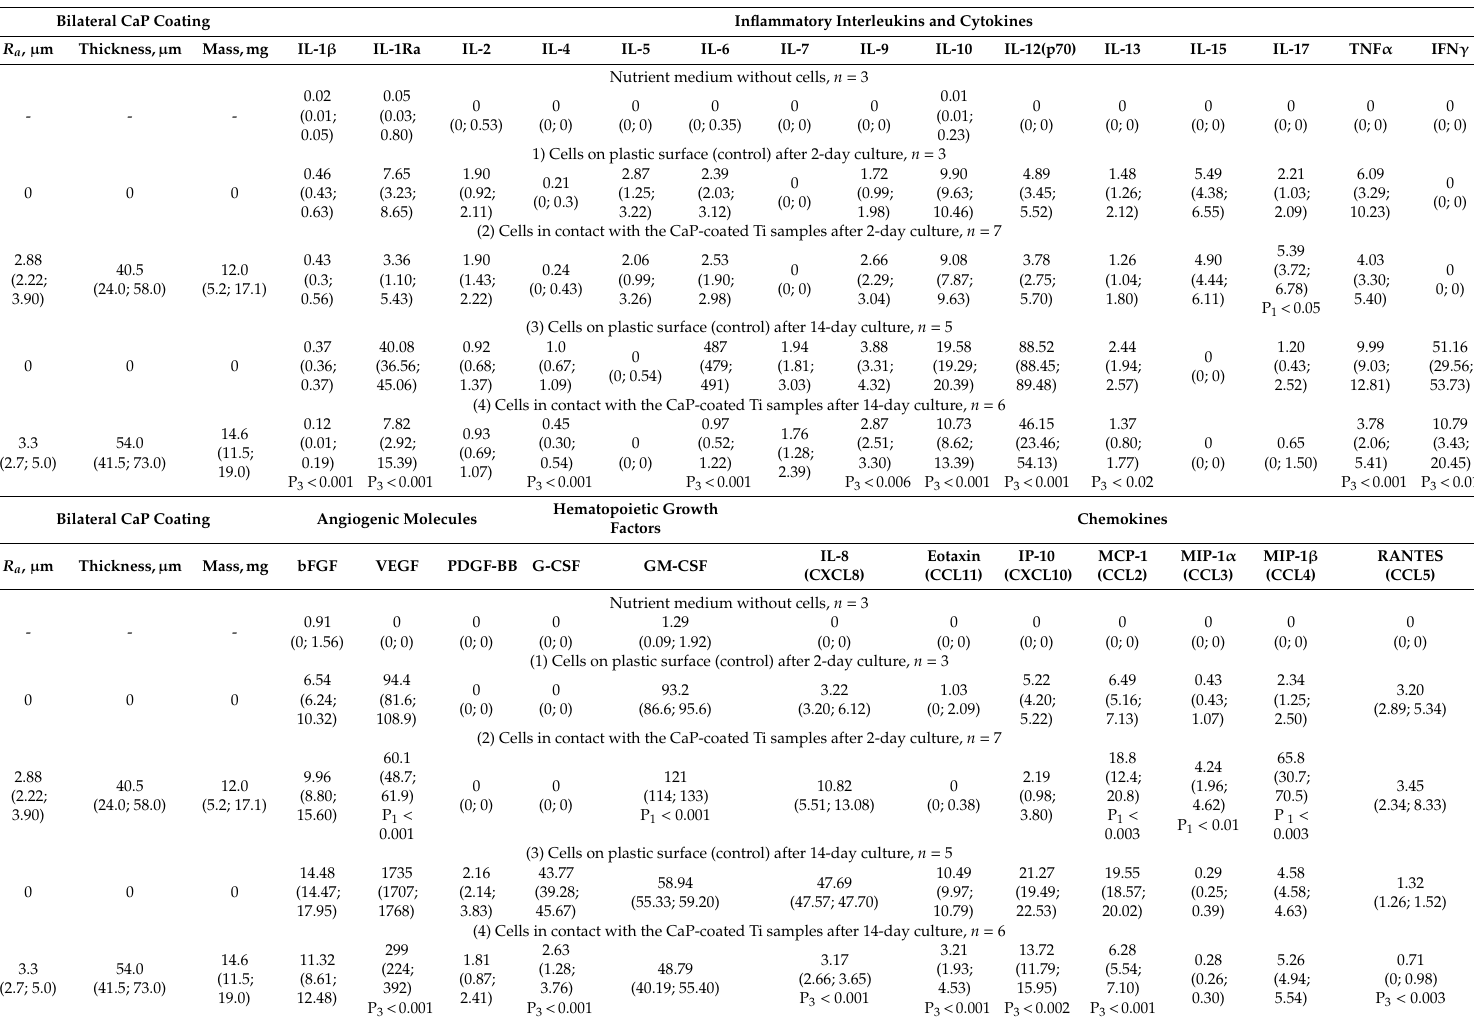
Table 4. Cytokine concentrations (pg / mL) in the supernatants of Jurkat T cells after di ff erent culture times in the presence of the CaP-coated Ti samples; Me (Q1; Q3). Bilateral CaP